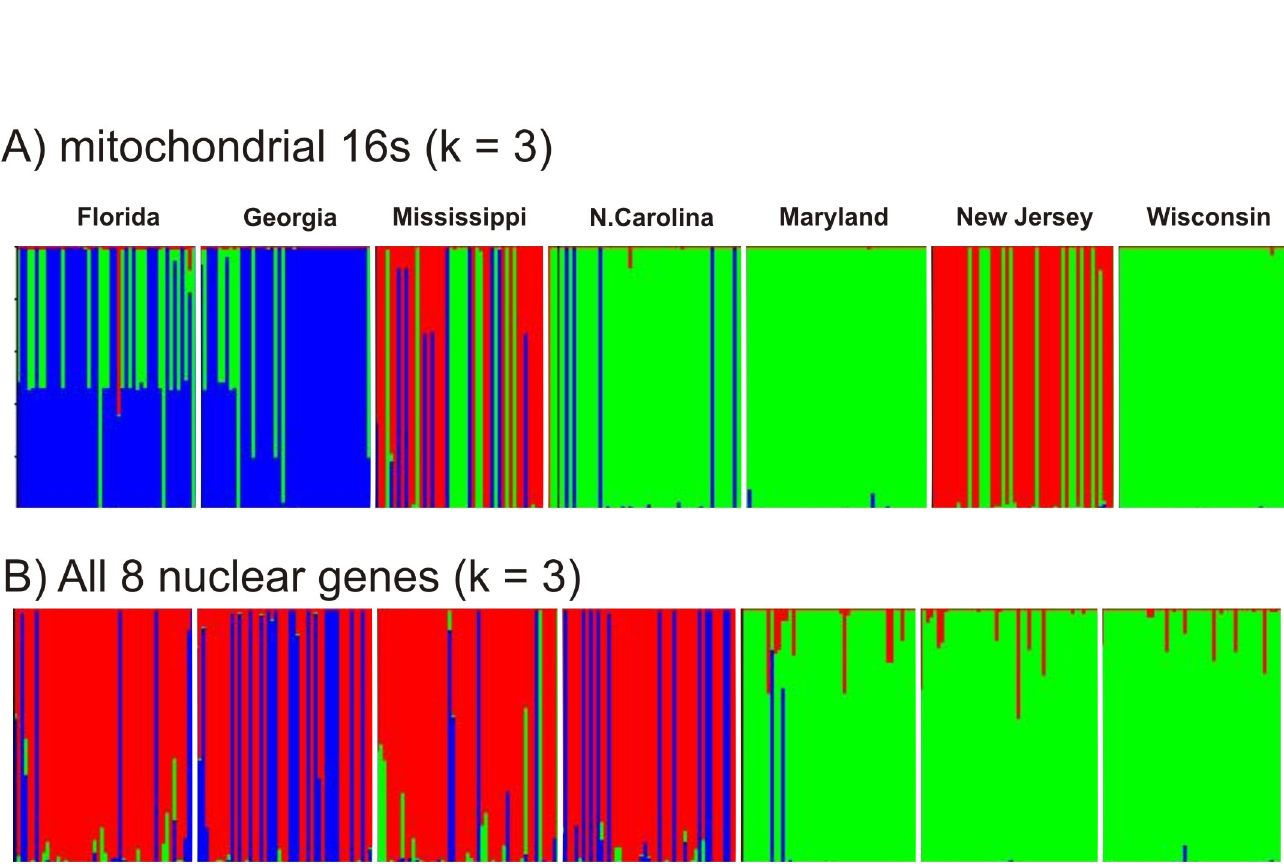
Fig 7. DISTRUCT plots created from STRUCTURE output. Cluster membership is represented as different colors, and individual ticks were depicted as vertical bars partitioned into segments that correspond to membership coefficients in each of the seven collection sites. The numbers of genetic clusters (K) of ticks was determined on the basis of their A) 16S haplotypes or B) for all 1,155 SNPs in the 8 nuclear genes